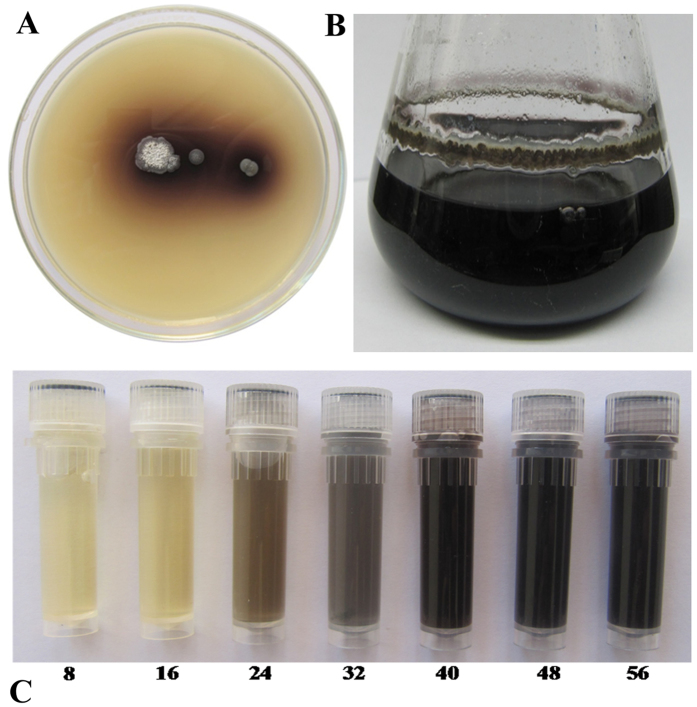
(A) Melanin production by Streptomyces glaucescens strain NEAE-H in peptone yeast extract iron agar; (B) culture broth after 2 days of incubation; (C) tubes containing culture samples at different elapsed times. Number below each vial indicates incubation time in hours.